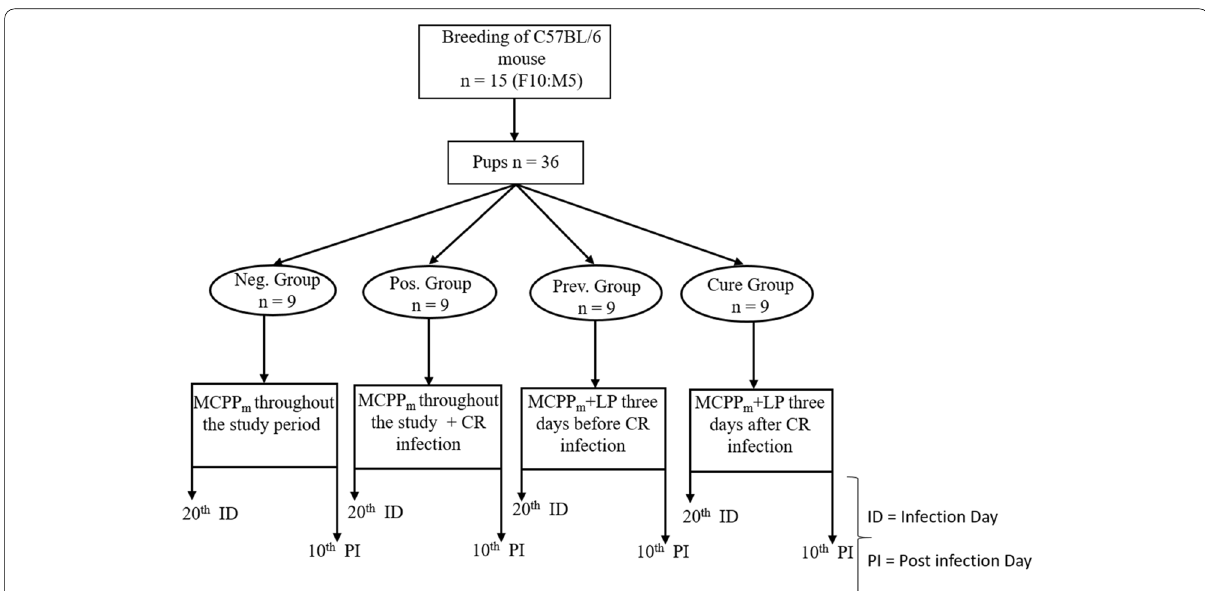
Fig. 1 Experimental design of the animal study. Upper rectangular boxes indicate breeding of C57BL/6 mice from Charles River (Charles River Laboratories, Wilmington, MA) bred for 36 weanling pups. The round circles indicate the different treatments with the number of weanling mice used in each group. The lower rectangular boxes indicate the diet treatment each group received, and the arrows are the days when mice were infected with Citrobacter rodentium and euthanized, respectively. C. rodentium (100 μL of 10 9 Log CFU/ml) was administered through oral gavage (on day 20 after birth) with the exception of the negative control. All mice groups were fed with the weanimix infant cereal diet 5 days prior to